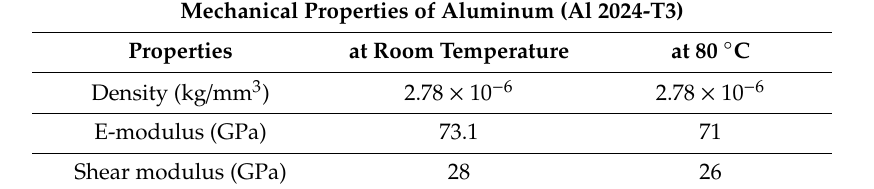
Table 2. Material properties of Al.